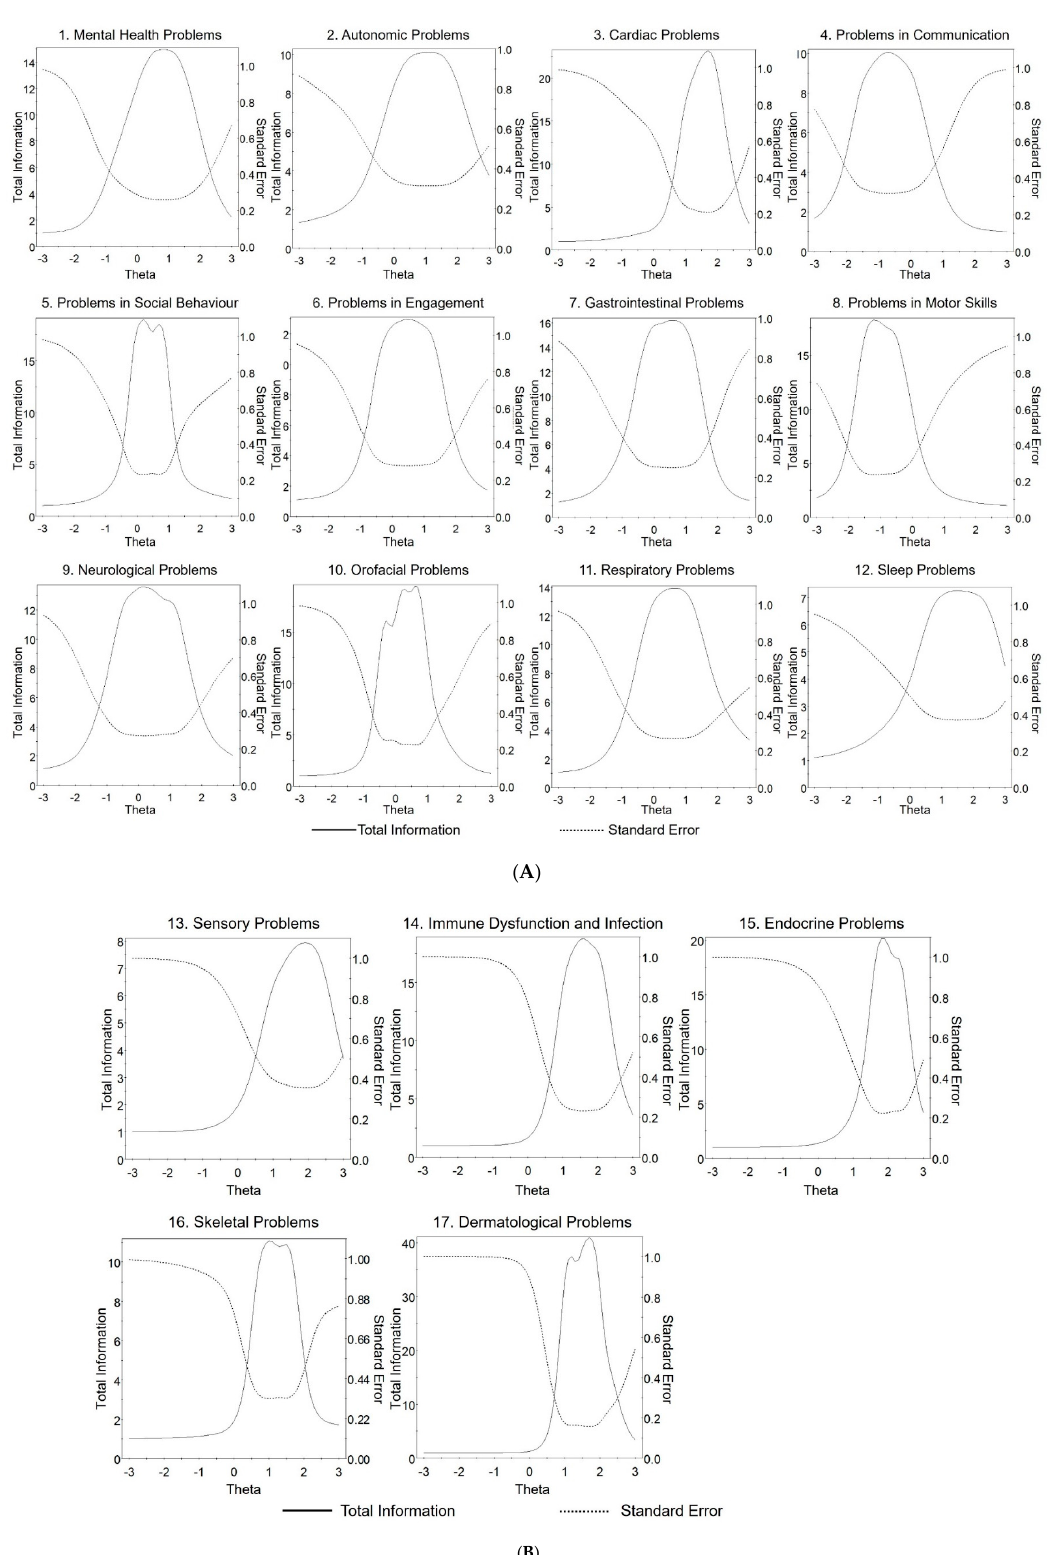
Figure 2. ( A ) Item characteristic curves for the sub-scale scores in the Multi-System Profile of Symptoms Scale (MPSS). ( B ) Item characteristic curves for the sub- scale scores in the Multi-System Profile of Symptoms Scale (MPSS) Supplement.